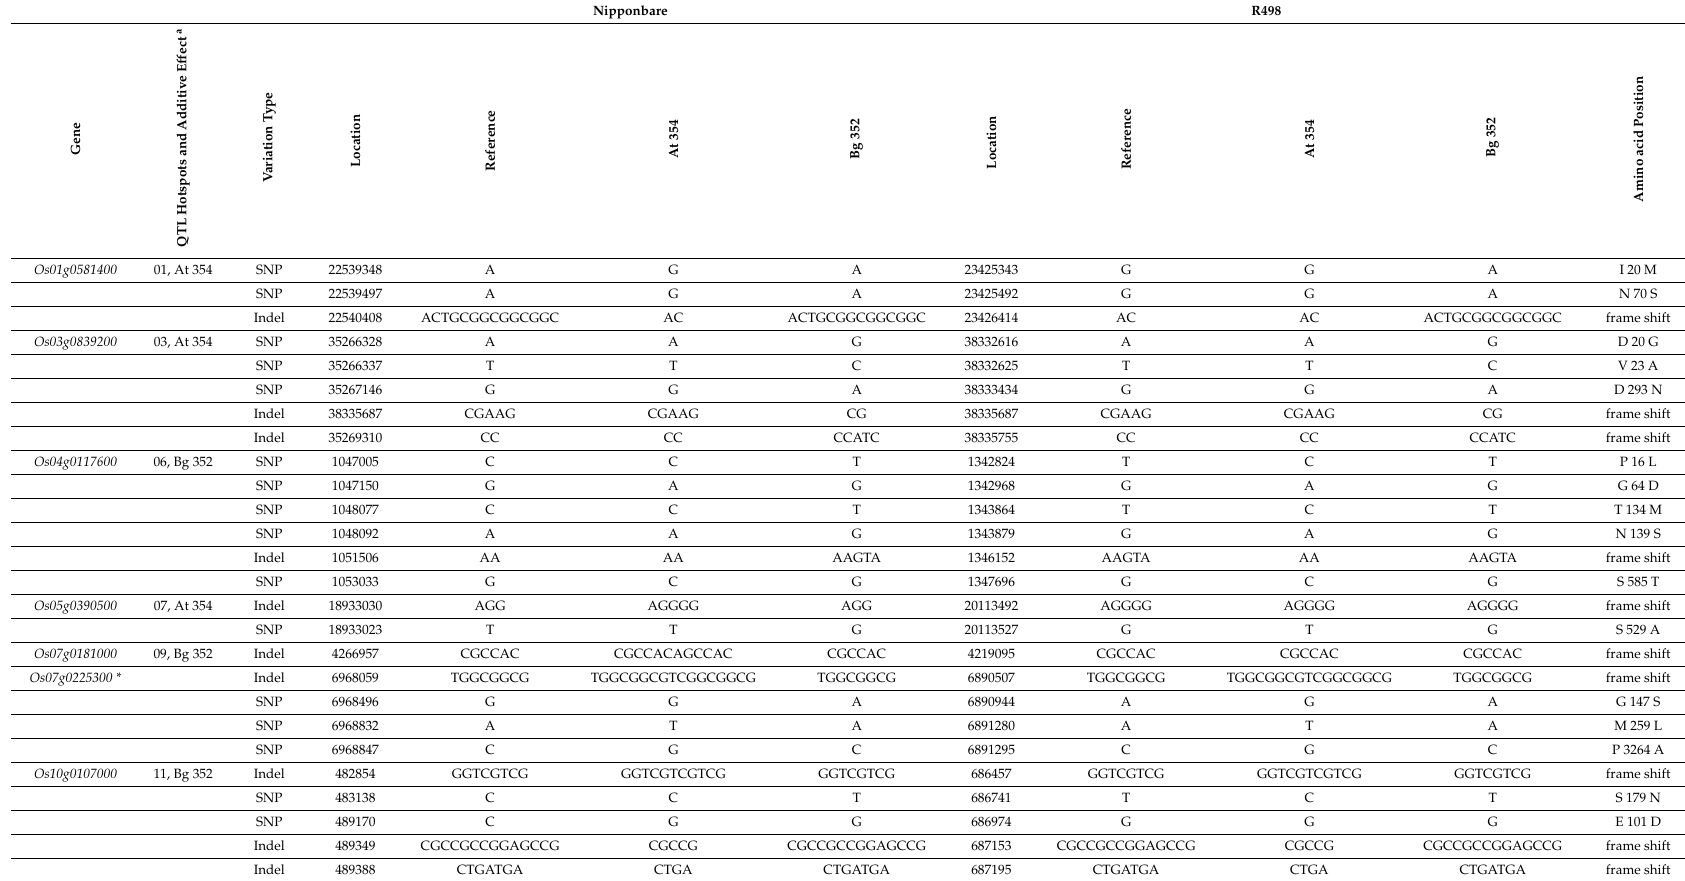
Table 3. Candidate genes identified based on polymorphic InDels in exons regions of two